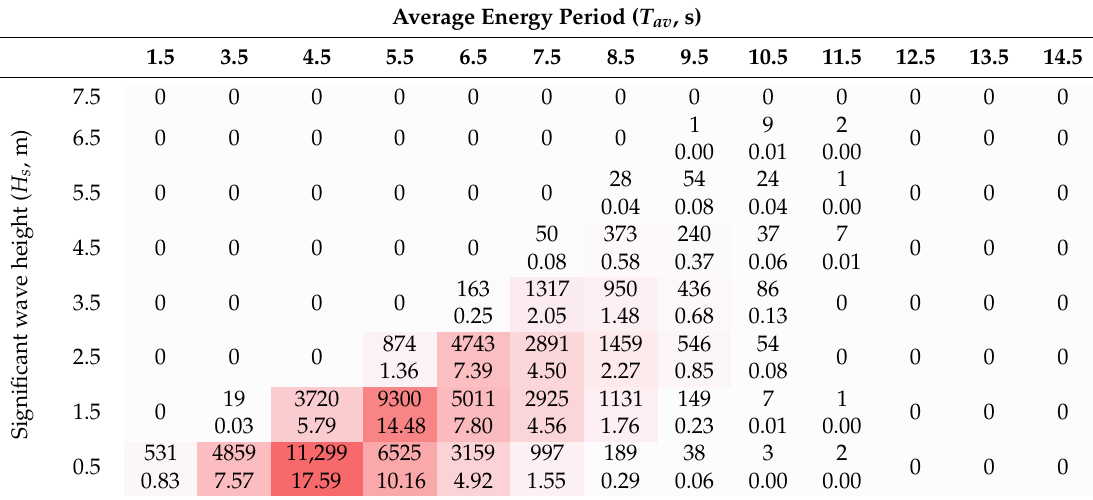
Table 5. Three-hourly wave energy statistics data (upper data, times) and probability of occurrence (underlying data,